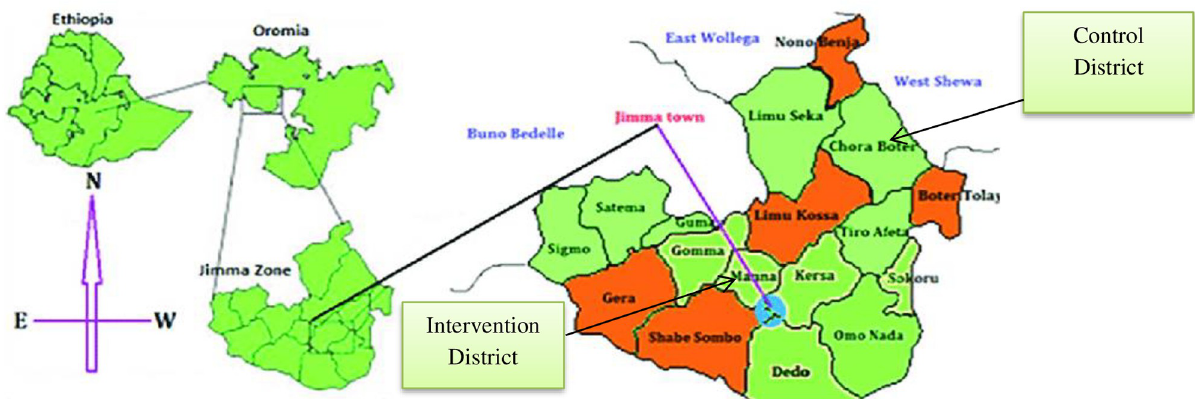
Fig 1. Map of Jimma Zone in Oromia region of Ethiopia showing the intervention and control districts. Source of base map: Kebede Y, Abebe L, Alemayehu G, Sudhakar M, Birhanu (2020) School-based social and behavior change communication (SBCC) advances community exposure to malaria messages, acceptance, and preventive practices in Ethiopia: a pre-posttest study. PLoS One 15(6):e0235189.